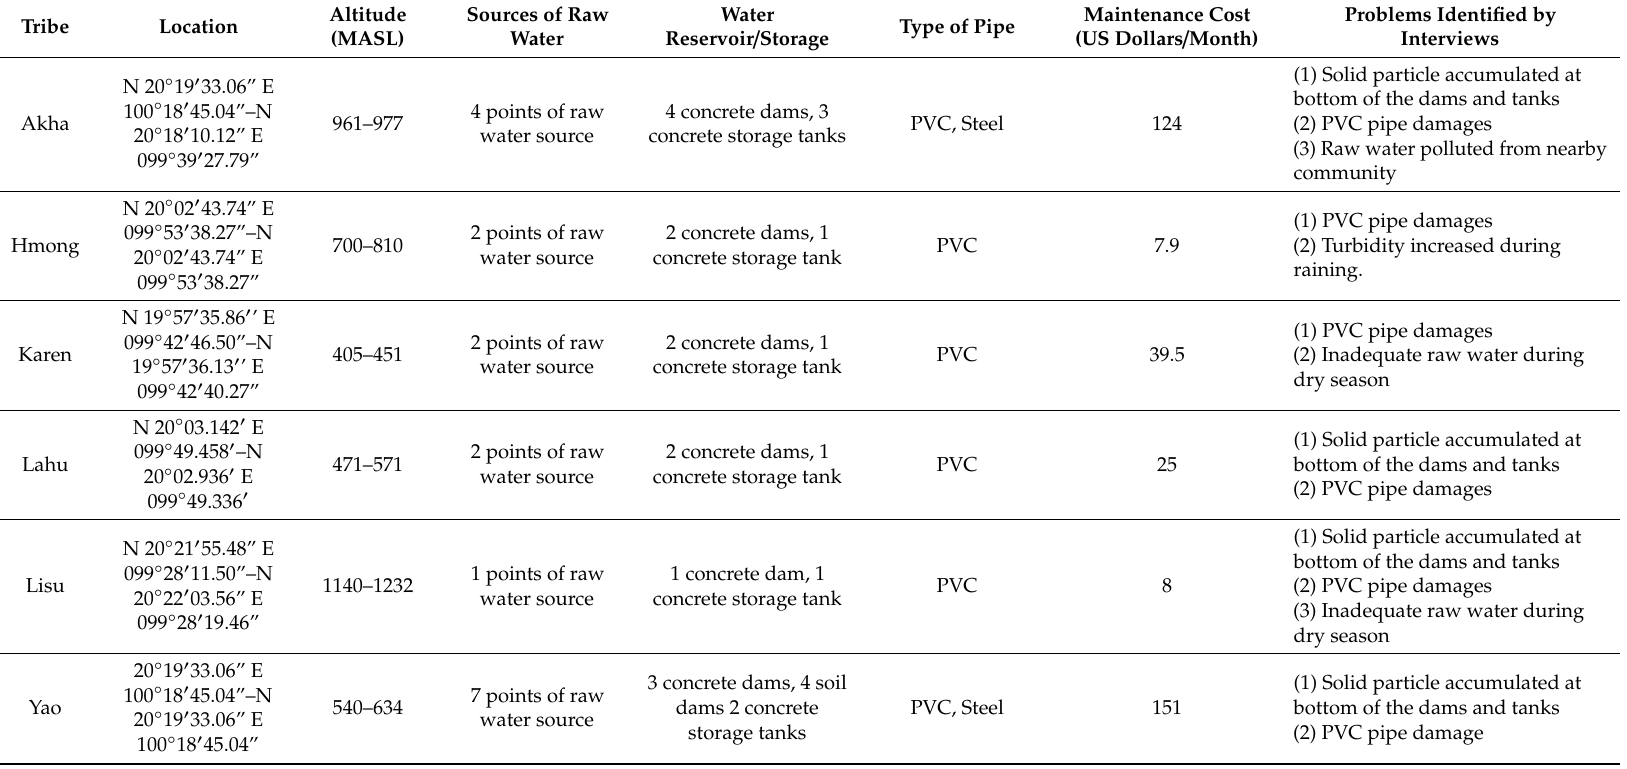
Table 4. Mountain water supply management of six hill tribe groups, Chiang Rai,